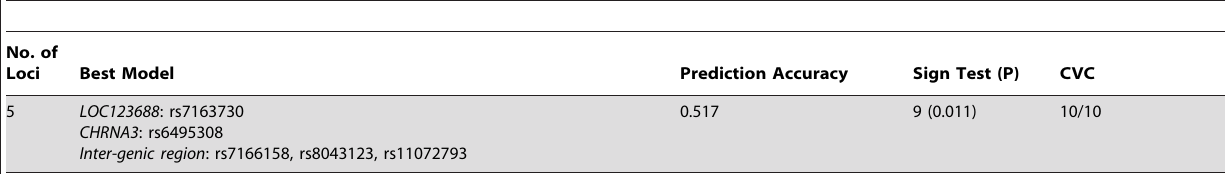
Table 5. A significant interactive model for CHRNA5/A3/B4 cluster with SI in KARE male sample on the basis of the prediction accuracy and the sign test P